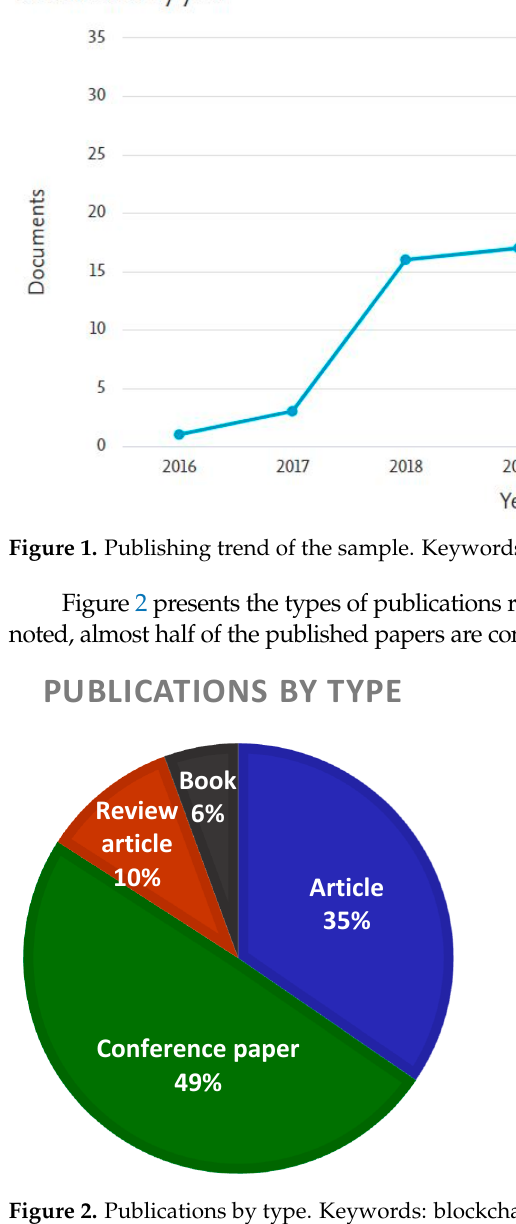
The obtained bibliometric data were used for further analysis as it allows for macro- level assessment in the field area [32]. VOSviewer software was used [32–34] to calculate and graphically present the matrix of keyword co-occurrence. It calculates the frequency of two keywords appearing together in one paper and, as a result, a symmetrical co-oc- currence matrix based on the word co-occurrence is obtained. Moreover, “the higher fre- quency of co-occurrence between keywords, the closer research theme is” [34]. In Table 1, keyword clusters based on the VOSviewer co-occurrence analysis are presented. Table 1. Clusters from bibliometric analysis. Cluster